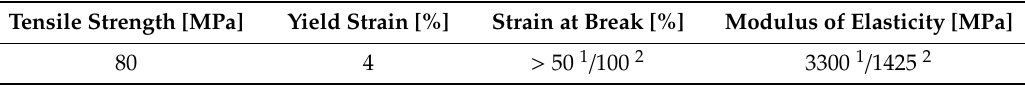
Table 2. Mechanical properties of Ertalon ® 6 SA under tensile loading (ISO 527-1 / -2) at 23 ◦ C [32]. Tensile Strength [MPa] Yield Strain [%] Strain at Break [%]